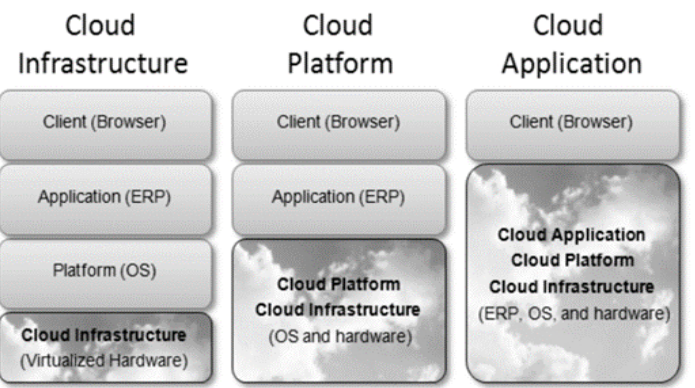
Figure 1. Types of cloud enterprise resource planning (C-ERP) [33]. (Reprinted with permission from ref. [33]. Copyright 2011 Springer Nature) ref. [33]. Copyright 2011 Springer